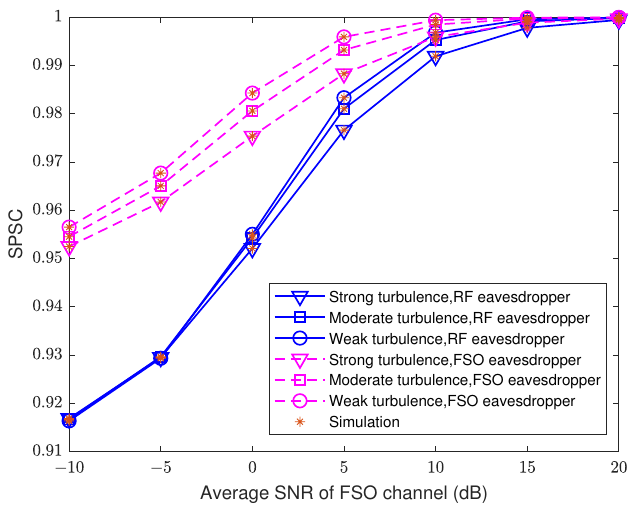
Figure 10. Under different turbulence conditions, the relationship between the SPSC of the hybrid system with RF and FSO link eavesdropping and the average SNR of the FSO